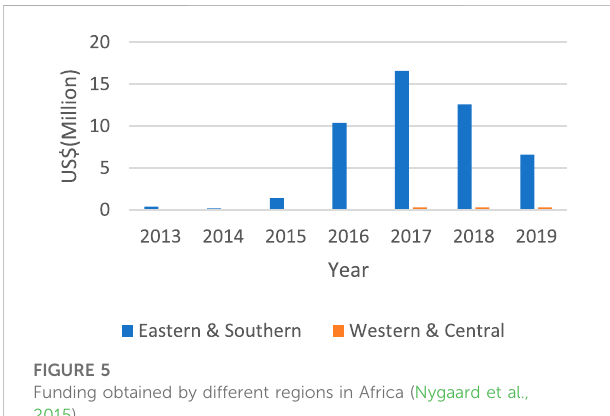
FIGURE 5 Funding obtained by different regions in Africa (Nygaard et al.,